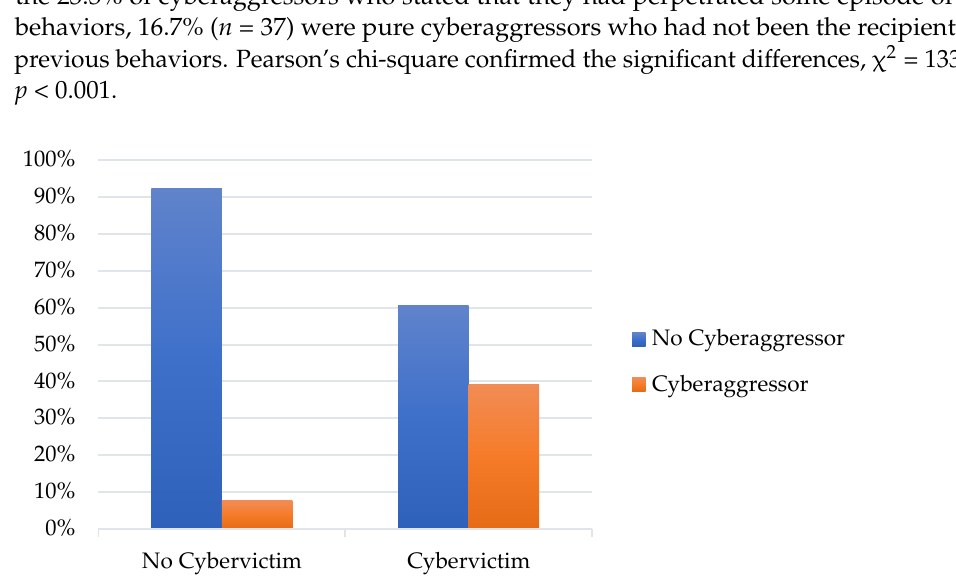
Figure 1. Percentage of cybervictims who are not cyberaggressors.